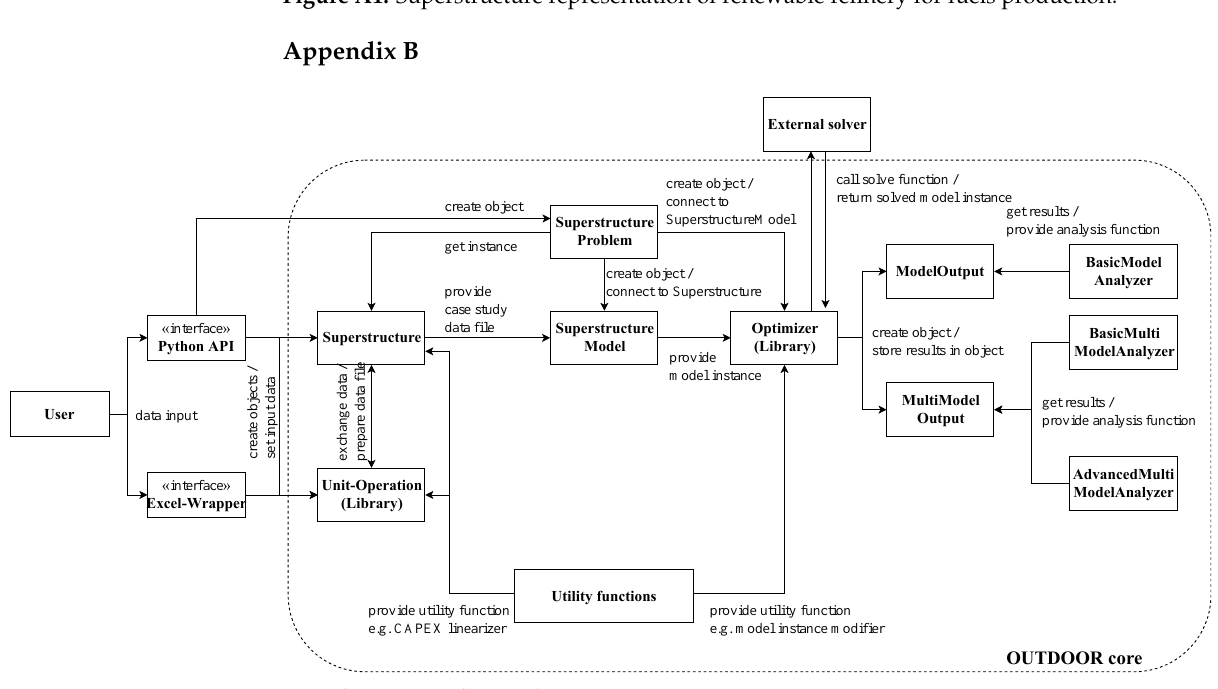
Figure B1. Representation of OUTDOOR software architecture. Figure A2. Representation of OUTDOOR software